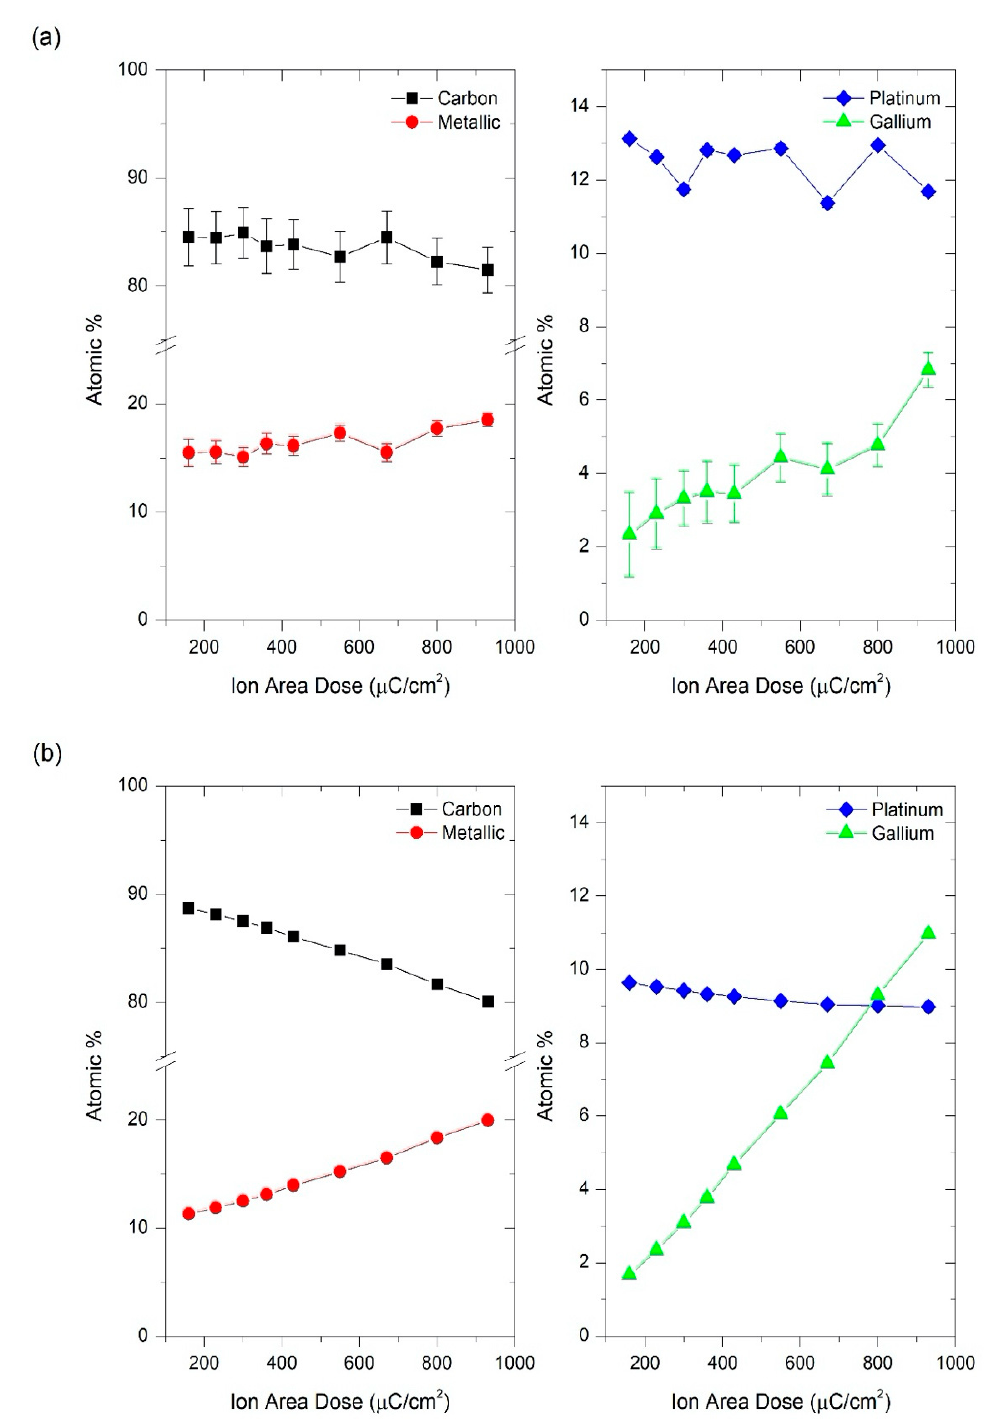
Figure 5. Atomic percentages as a function of the ion area dose of Pt-C cryo-deposits grown at 5 kV. ( a ) Experimental EDS compositional results. Left: carbon and metallic (platinum plus gallium) content. Right: platinum and gallium content; ( b ) Compositional results extracted from MC simulations at a depth of 15.25 nm (center of the deposit). Left: carbon and metallic (platinum plus gallium) content. Right: platinum and gallium content.